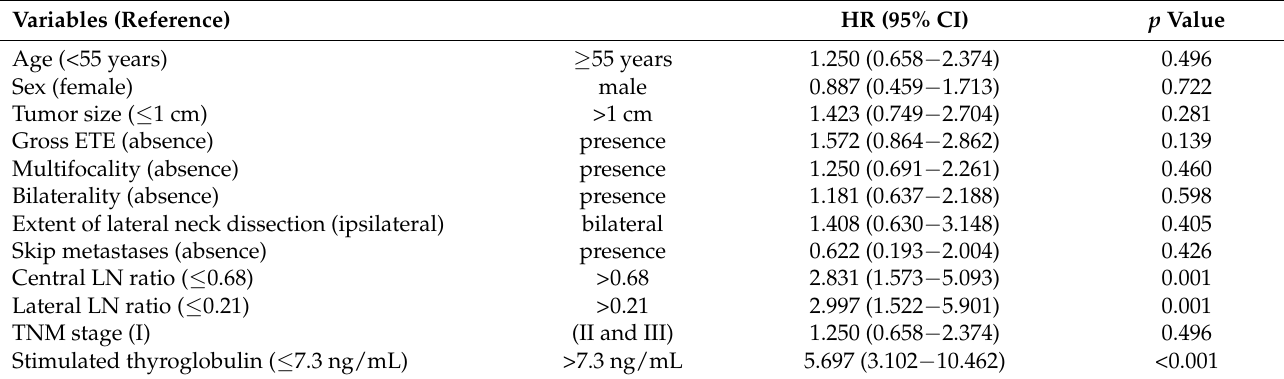
Table 4. Univariate analysis related to recurrence.